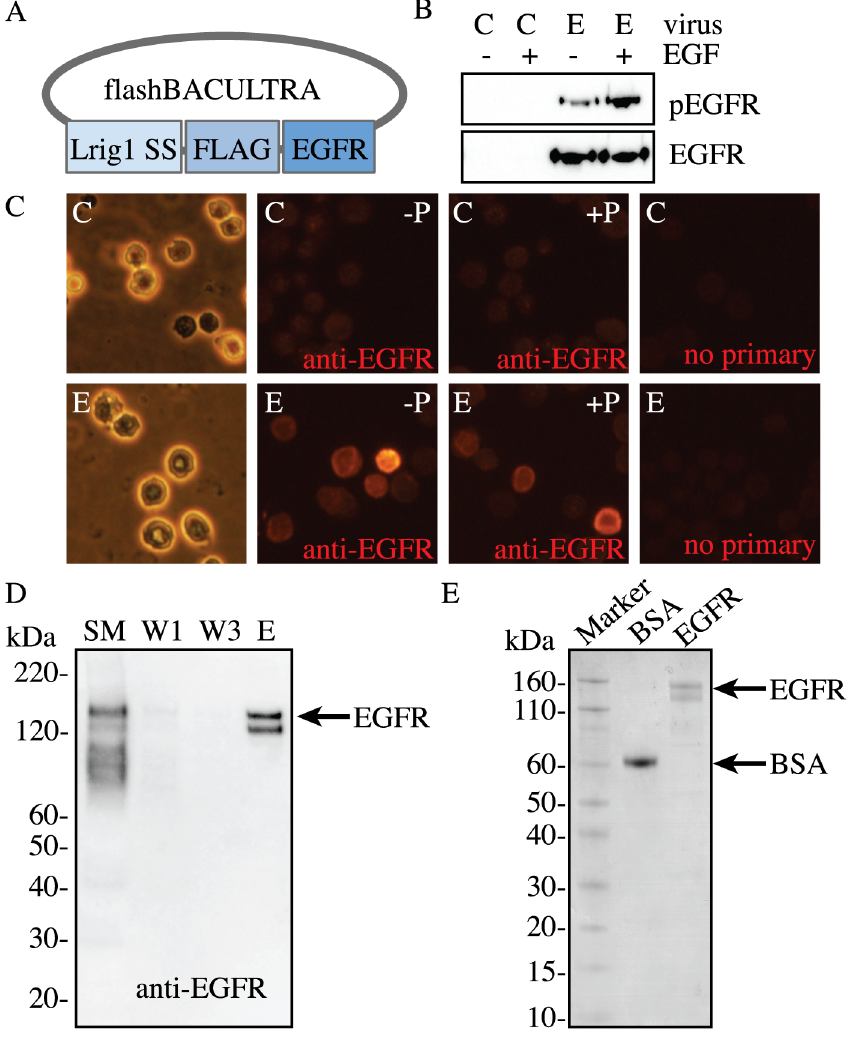
Fig 1. Baculovirus-expressing EGFR production. A ,Mapof theEGFR baculovirususingthe flashBACULTRA system with a FLAG epitopeplacedbetweenthe leadersequencepeptide(Lrig1SS) and the full-length mammalian EGFR sequence(EGFR). B , Sf9 insect cells were infectedwith a MOI of 10 of control baculovirus (C) or EGFR baculovirus (E) for 48 hours followedby collectionof total cell lysate andWestern Blottingto detect EGFR expression.A set of these cellswas treated with 10 ng/ml EGF in orderto detect ligand-induced receptor phosphorylation. C , Sf9 insect cells were seededon glass coverslipsand infectedwith an MOI of 10 of control(C) or EGFR (E) baculovirus for 48 hours. Cells werefixed in 4% paraformaldehydefollowedby immunostainingwith anti-EGFR antibody(in red) with (+P) or without(-P) permeabilizationin 100%methanol. The brightfieldimageshows cell morphology.Cellsincubatedwith secondary antibodyin the absenceof EGFR antibody(no primary) were used as a negativecontrol. D , FLAG-EGFR is readilypurifiedfrom Sf9 insect cells as shownby a representative imageof anti-EGFR immunoblotof FLAG EGFR purificationand E , a Coomassie-stainedSDS-PAGE gel. Bovineserum albumin(BSA) was loadedas a proteinof known concentration. Total insect cell lysate startingmaterial(SM), purification washes1, 3 (W1, W3), andelution(E) wereloadedto show efficiency of the FLAG-purification. 2629933 vs. 2003750, respectively) (Fig 2 B ). Egg PC:ApoA1 and EGFR:ApoA1 ratios were opti- mized as displayed in S1 A and S1 B Fig. NLP assemblies with a broad peak can be rerun to obtain NLPs of a uniform size (S1 C Fig). We next assessed the size distribution of the NLPs by dynamic light scattering (DLS). Both empty and EGFR-NLPs+EGF had relatively small size